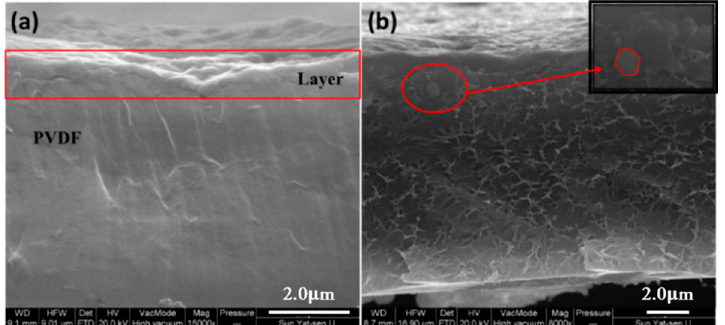
Figure 8. Cross sectional SEM image of 11QLs coated onto PVDF film with different fractions ( a ) and ( b ).